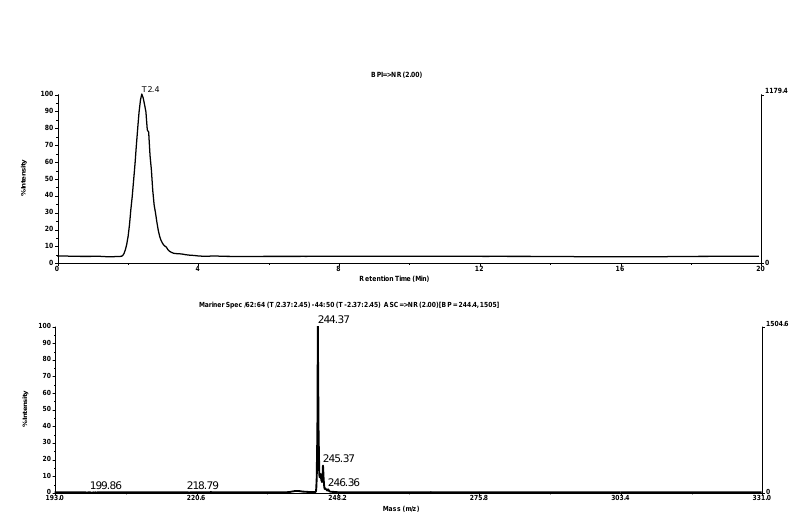
Figure 2. Chromatogram and spectra of LC-MS